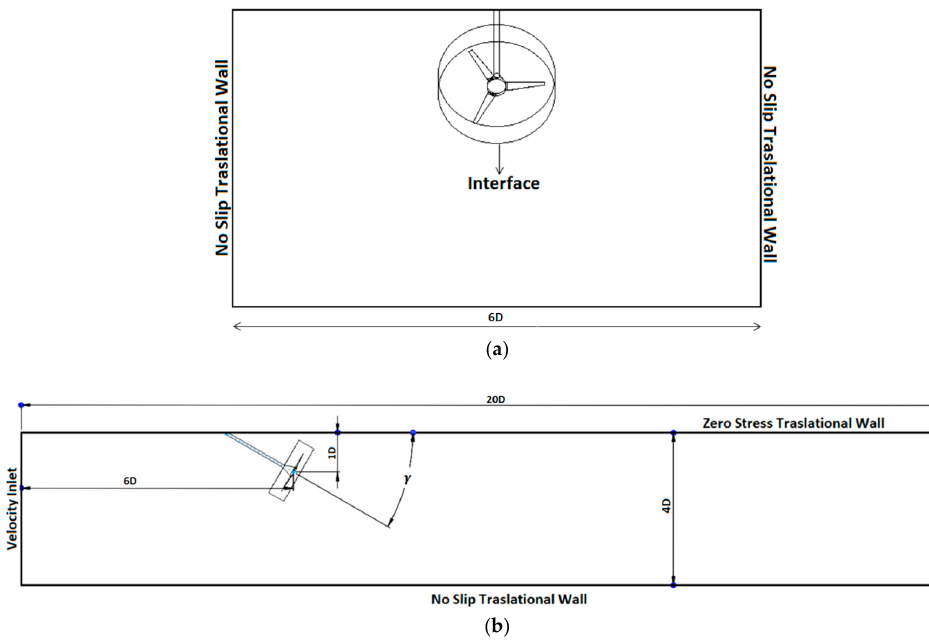
Figure 2. The front view ( a ) and side view ( b ) of the geometry for the inclined HAHT. The employed boundary conditions are also